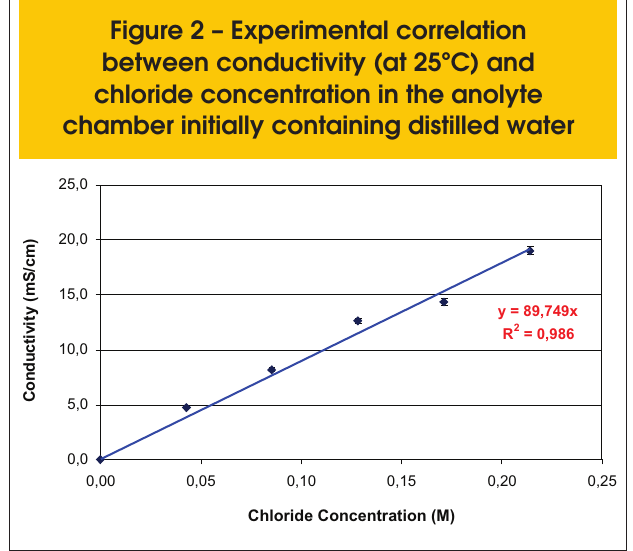
Figure 2 – Experimental correlation between conductivity (at 25ºC) and chloride concentration in the anolyte chamber initially containing distilled